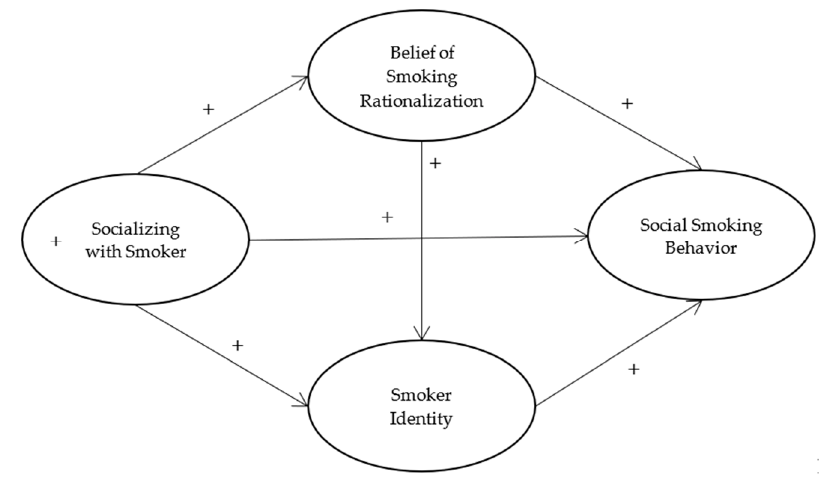
Figure 1. Conceptual